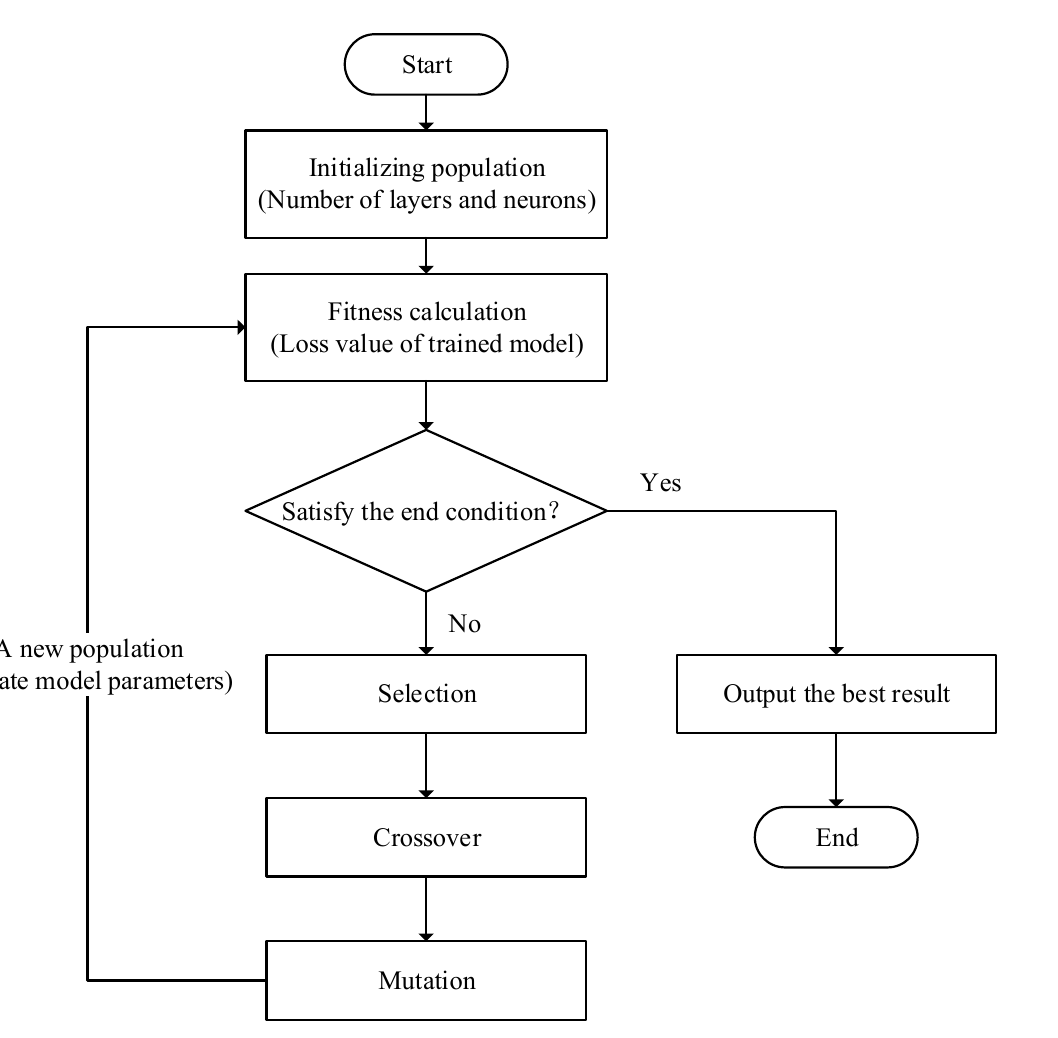
Figure 2. Flow chart of genetic algorithm.